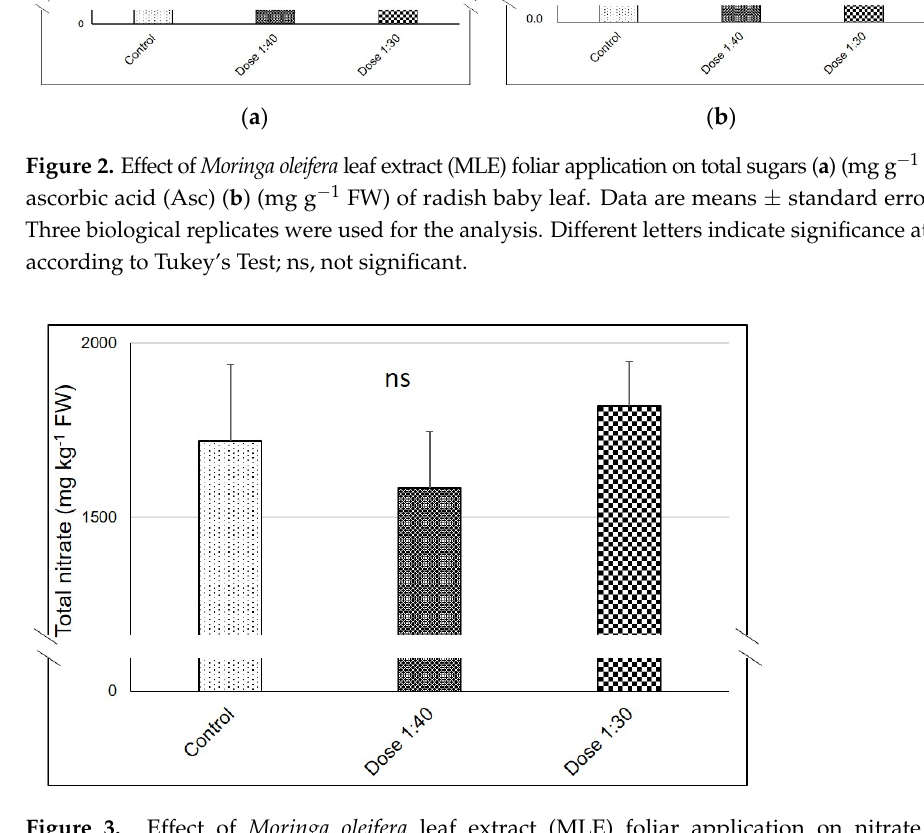
Figure 3. Effect of Moringa oleifera leaf extract (MLE) foliar application on nitrate content (mg kg − 1 FW) of radish baby leaf. Data are means ± standard error ( n = 3). Three biological replicates were used for the analysis. Different letters indicate significance at p < 0.05 according to Tukey’s test; ns, not significant.